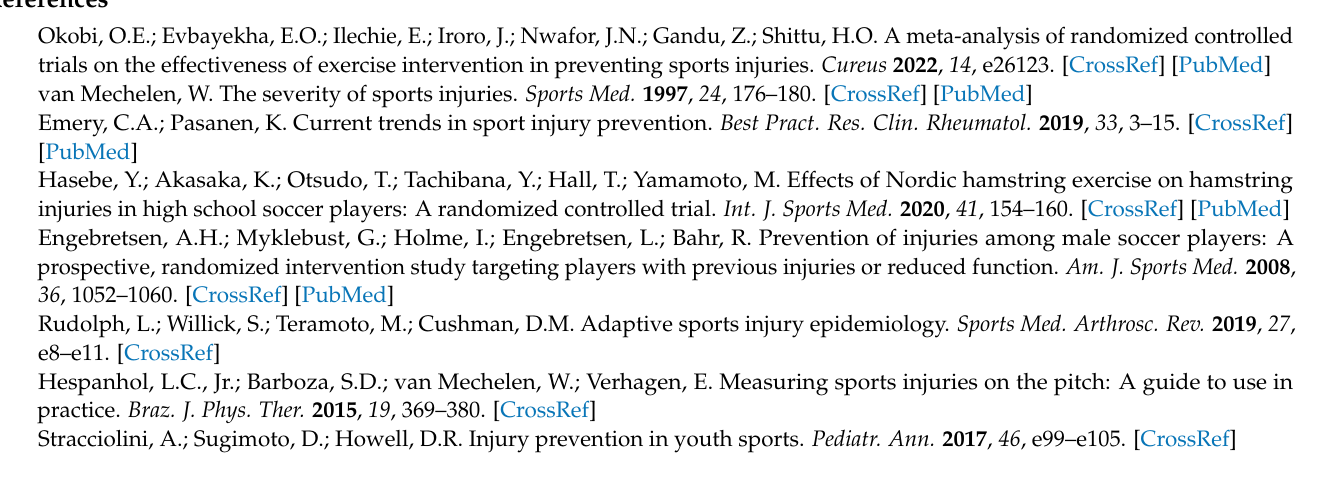
Table S2: The results of the GRADE system; Table S3: Literature search